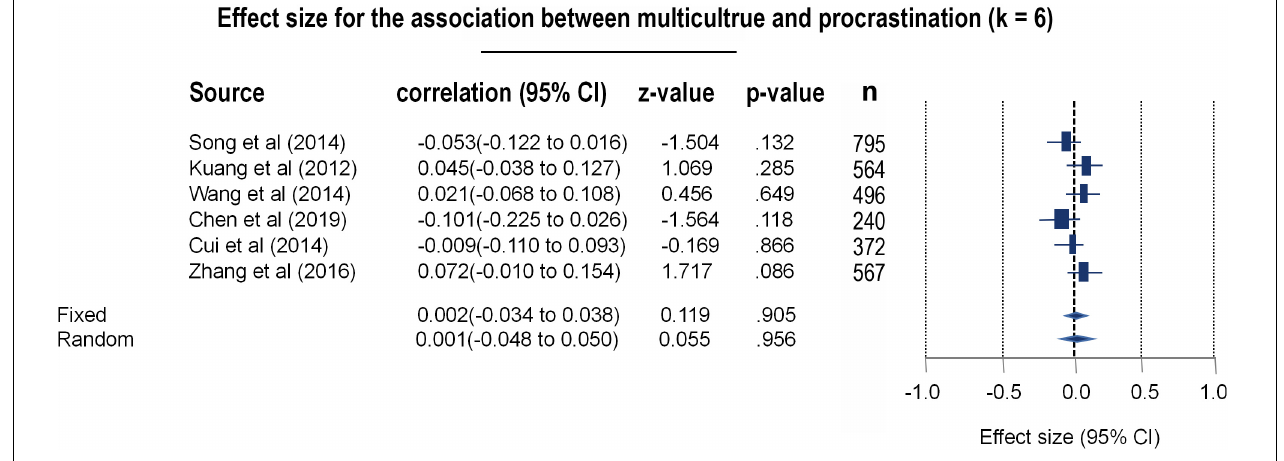
FIGURE 4 | Forest plot for the meta-analytic results toward multi-cultural differences of procrastination.